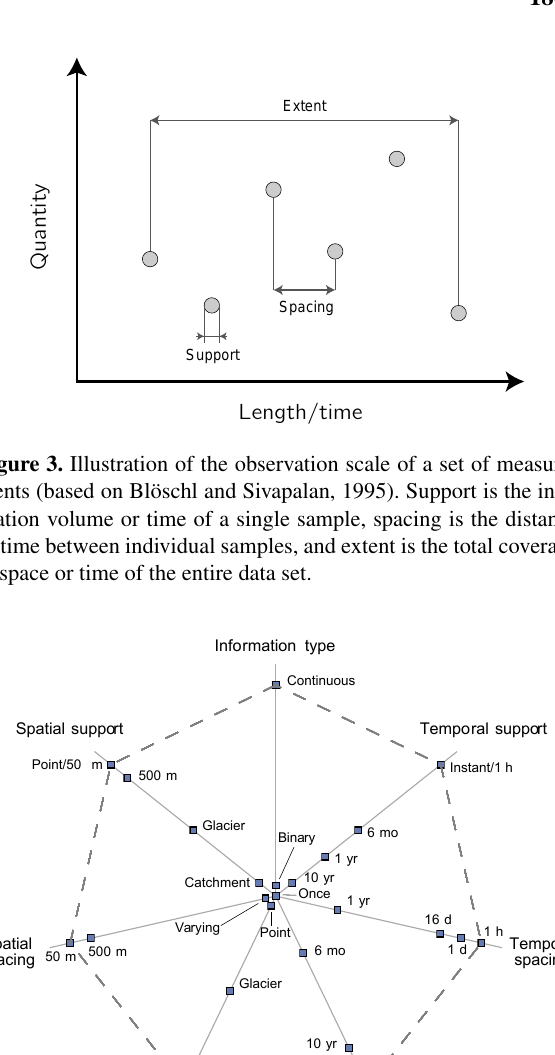
Figure 2. Negative openness of a subset of the study area for length scales L = 50m and L = 5000m (top), and the snow redistribution factor derived by a combination of both data sets (bottom; black frame shows the boundaries of the upper plots).